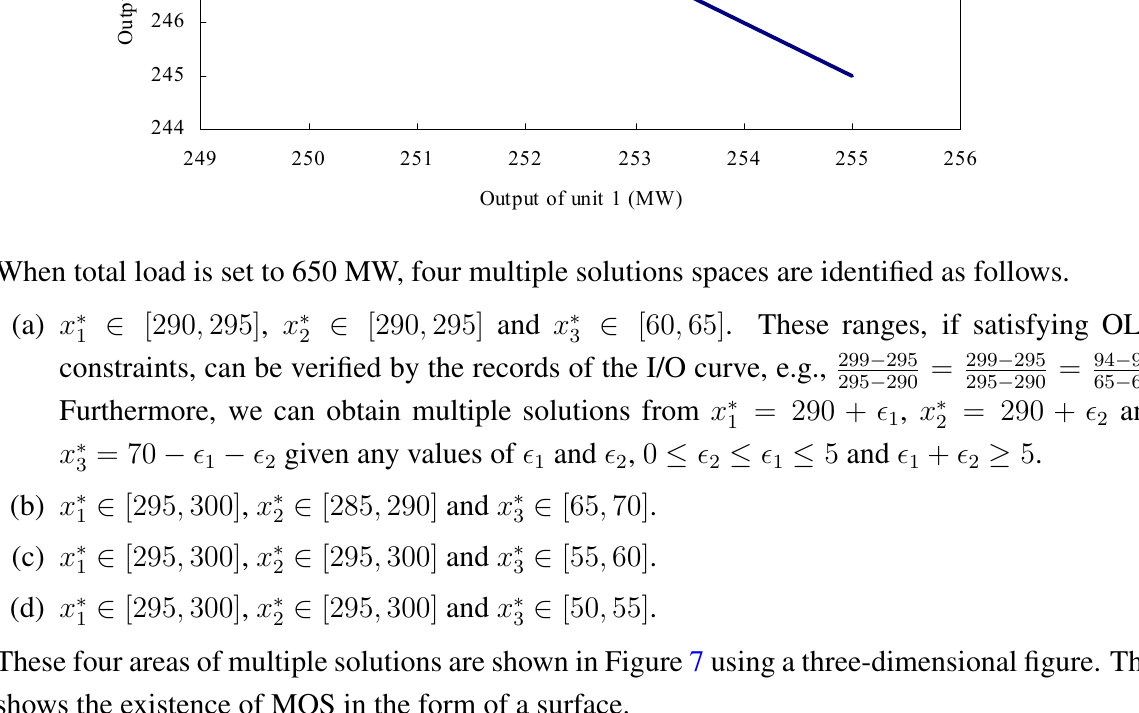
Figure 7. Multiple solutions space to total electric load of 650 MW (output of unit 1 ≥ output of unit 2 ≥ output of unit